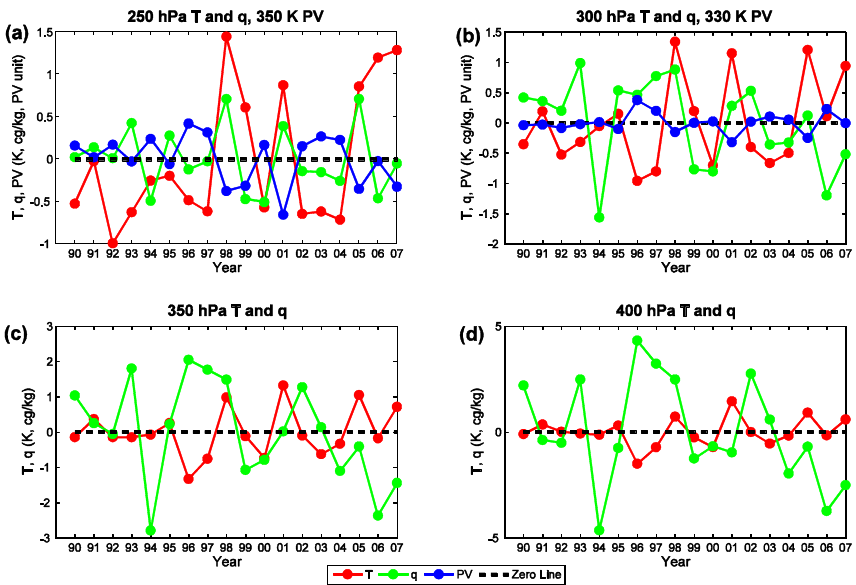
Figure 10. Irene (25.5–32.2 ◦ S, 24.8–31.5 ◦ E) May-June-July-August (MJJA) temperature ( T ) and specific humidity ( q ) anomalies for four Figure 11 pressure levels and potential vorticity (PV) anomalies for two isotropic levels.